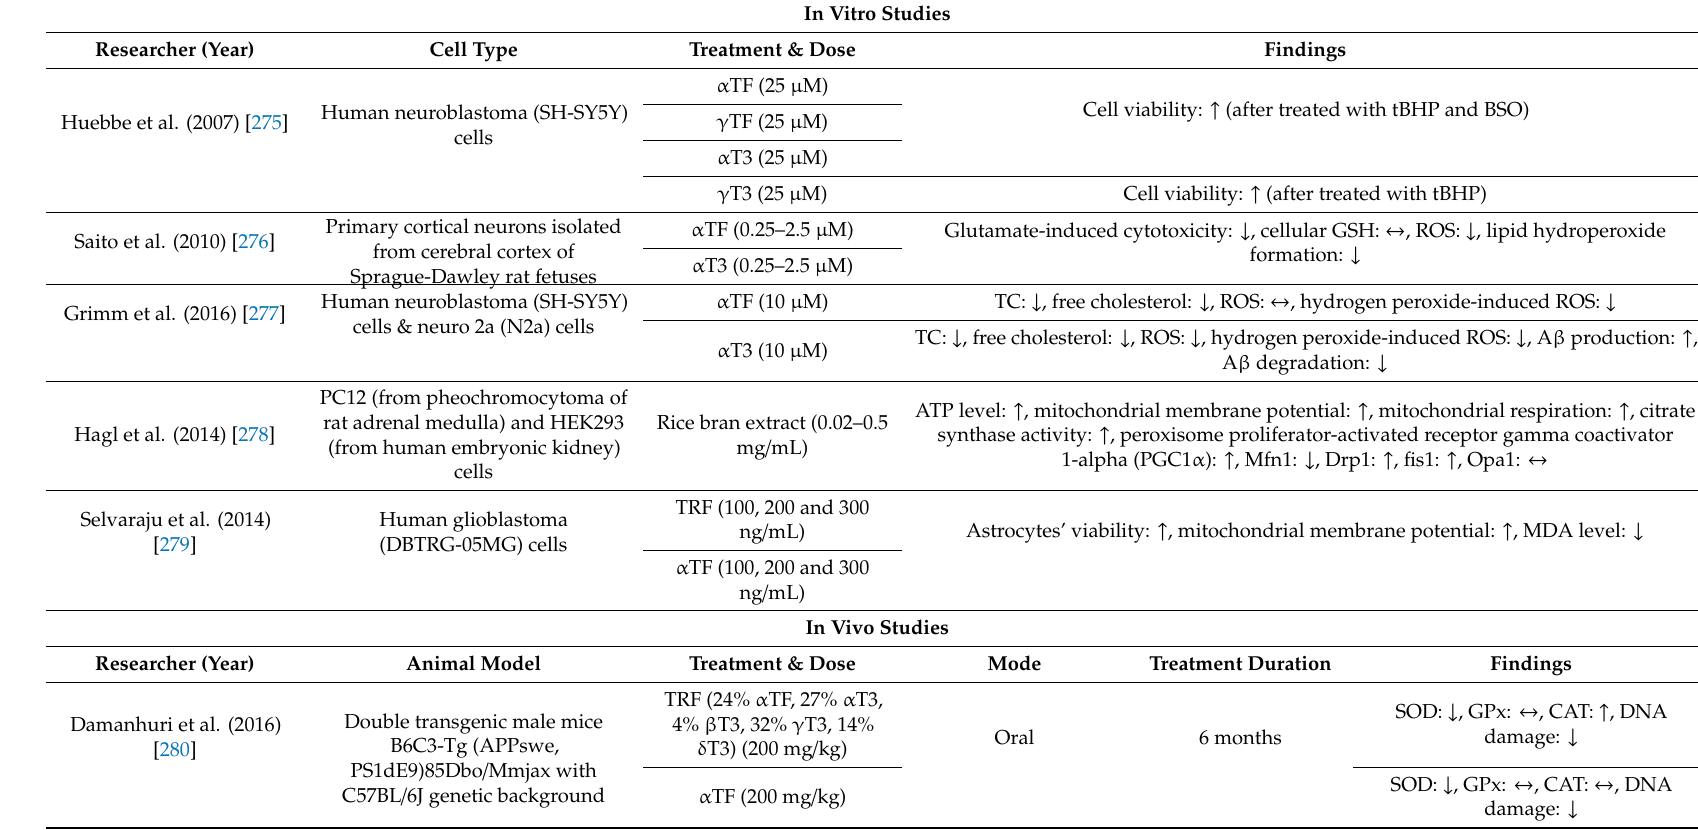
Table 13. E ff ect of T3 on Alzheimer’s